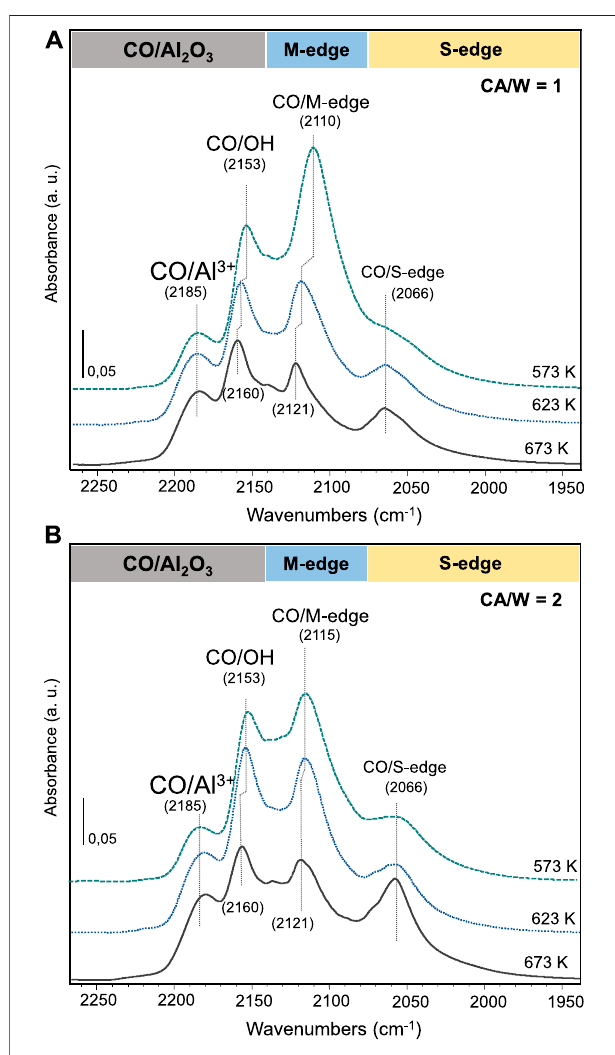
FIGURE8| IRspectraofCOadsorbed(133 Paatequilibrium,100 K)on (A) W/Al 2 O 3 CA (cid:1) 1 and (B) W/Al 2 O 3 CA (cid:1) 2 catalyst sul fi ded with 10% H 2 S/ H 2 at different